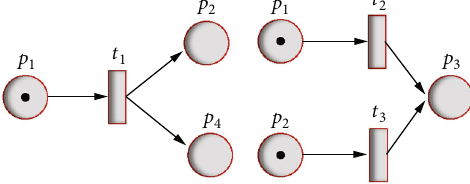
Figure 3: Con fl icted relationship of an SPN